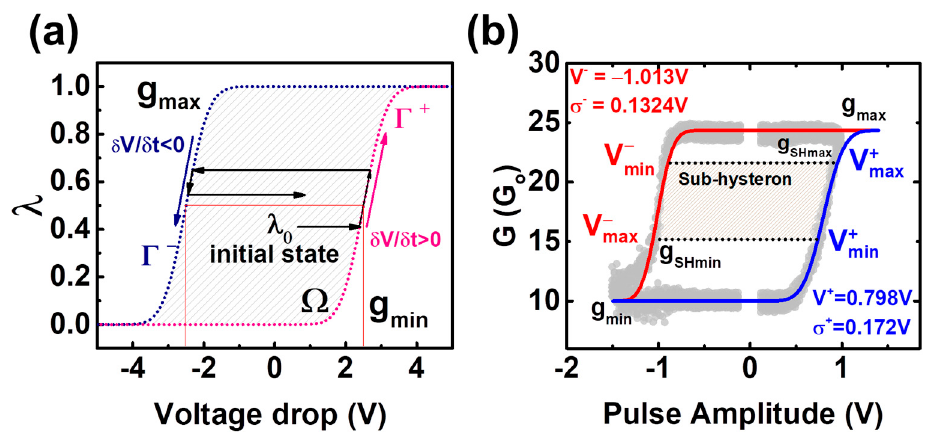
Figure 6. ( a ) Ideal hysteron function of a non-linear memristive device [31]. ( b ) Examples of experimental (gray dots) and an example of a fitted particular case (blue and red lines) G–V characteristics. The fitting parameters V ± and σ ± are also indicated at the top left and bottom right parts of the figure.